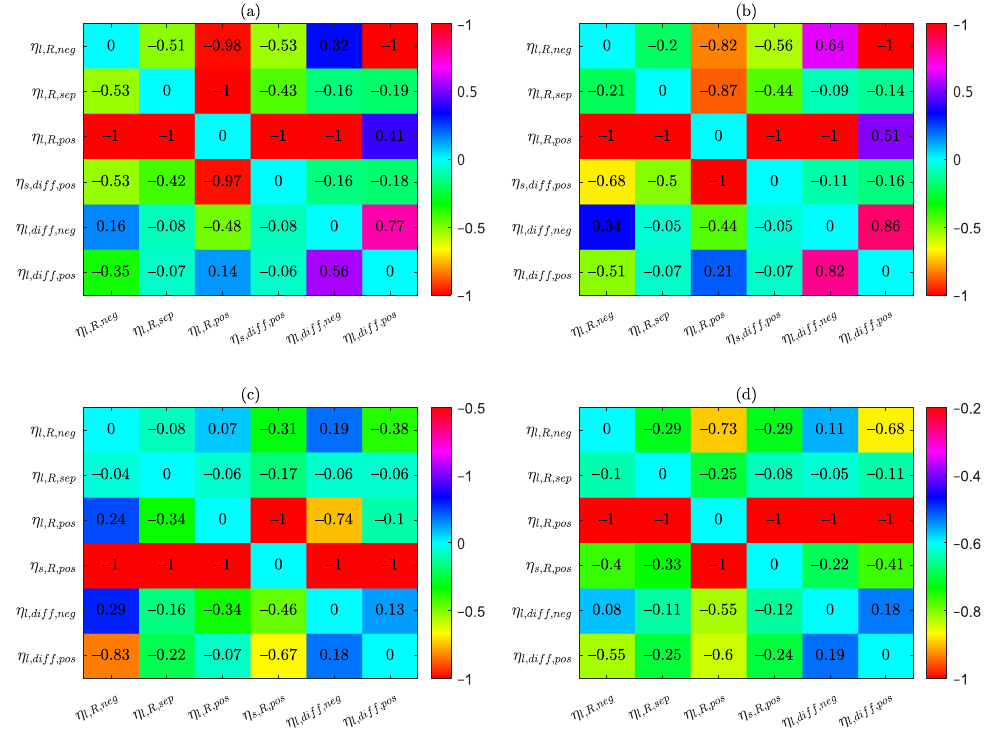
Figure 10. Correlation chart for cases 1–4, where each column in the matrix represents the correlation coefficients with the tested